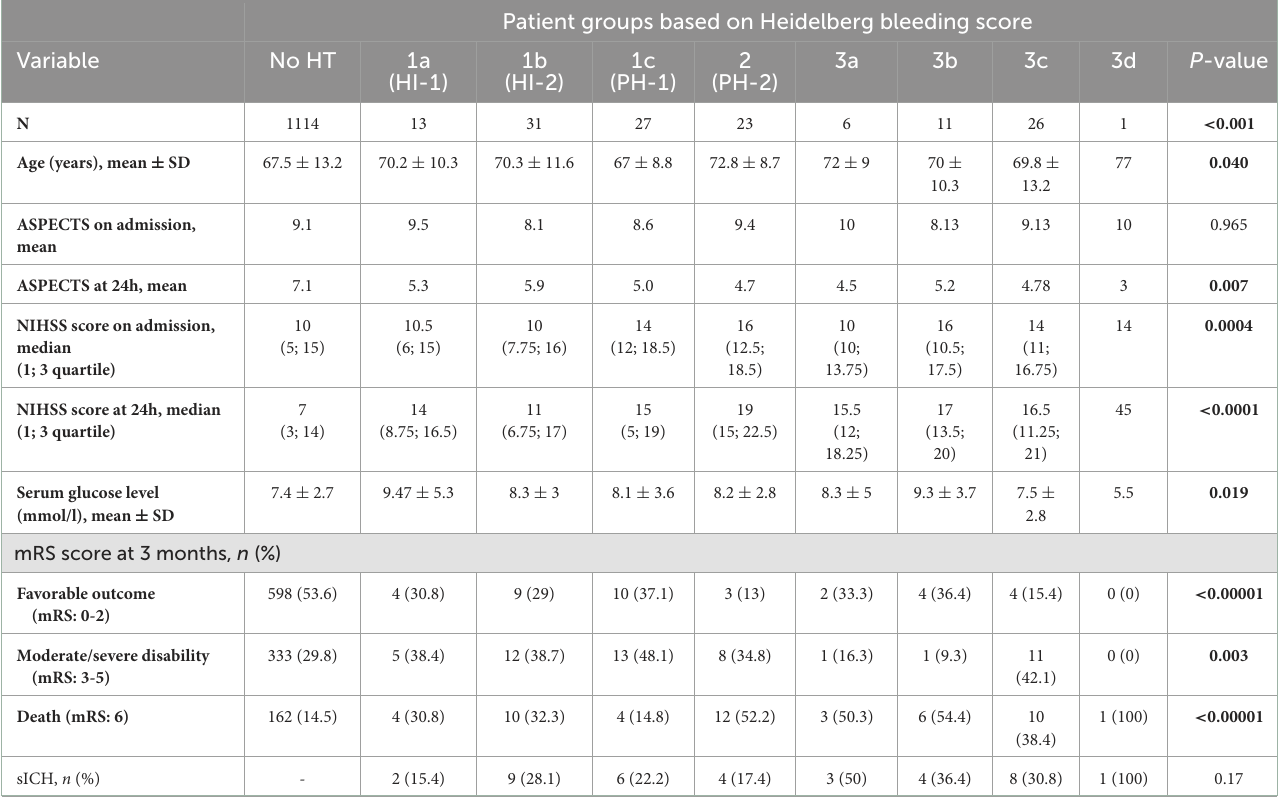
TABLE 3 Baseline characteristics, functional outcome at 3 months, and rate of sICH in patient groups based on Heidelberg bleeding score. Patient groups based on Heidelberg bleeding